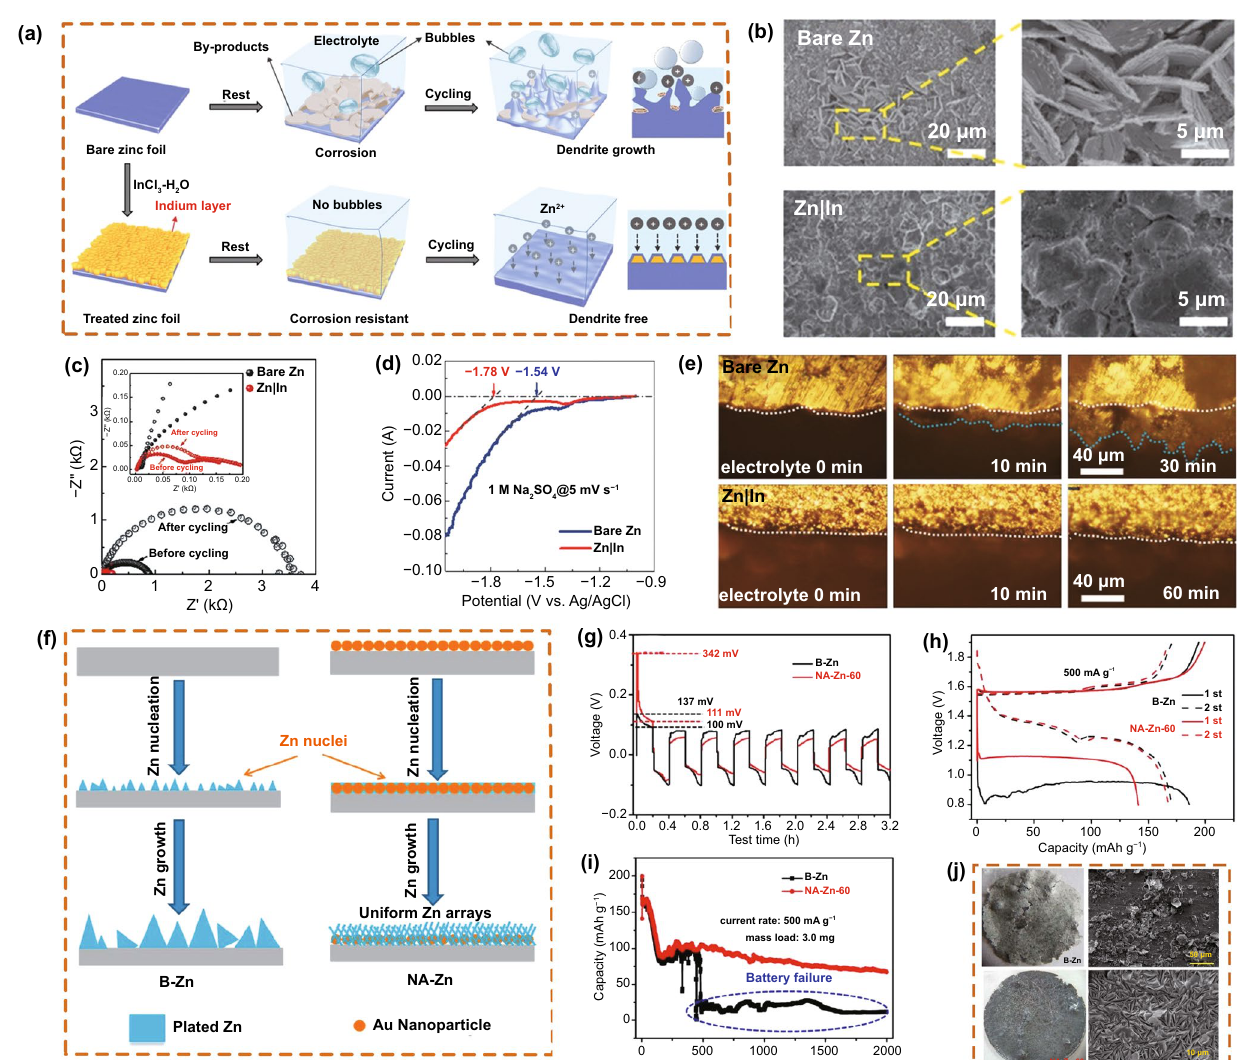
Fig. 6 a Schematics and characterization of Zn and Zn|In foils. b SEM images of bare Zn and Zn|In in symmetrical cells after the first plating process at 1 mA cm −2 for 1 mAh cm −2 . c Electrochemical impedance spectroscopy of bare Zn and Zn|In before and after cycling in symmetrical cells with an aqueous ZnSO 4 electrolyte and d Linear sweep voltammetry curves of bare Zn and Zn|In in a 1 M aqueous Na 2 SO 4 electrolyte at a scan rate of 5 mV s −1 . e Operando optical microscope images of bare Zn and Zn|In in an aqueous ZnSO 4 electrolyte. Copyright 2020 Wiley- VCH [93]. f Schematic illustration of the Zn stripping/plating process on a bare Zn and NA-Zn. g Initial discharge/charge profiles of Zn|Zn sym- metrical cells at a current density of 0.25 mA cm −2 . h Voltage profiles. i Cycling performance of Zn|CNT/MnO 2 cells at 500 mA g −1 . j Optical and SEM images of bare Zn anode and NA-Zn-60 anode. Copyright 2019 American Chemical Society